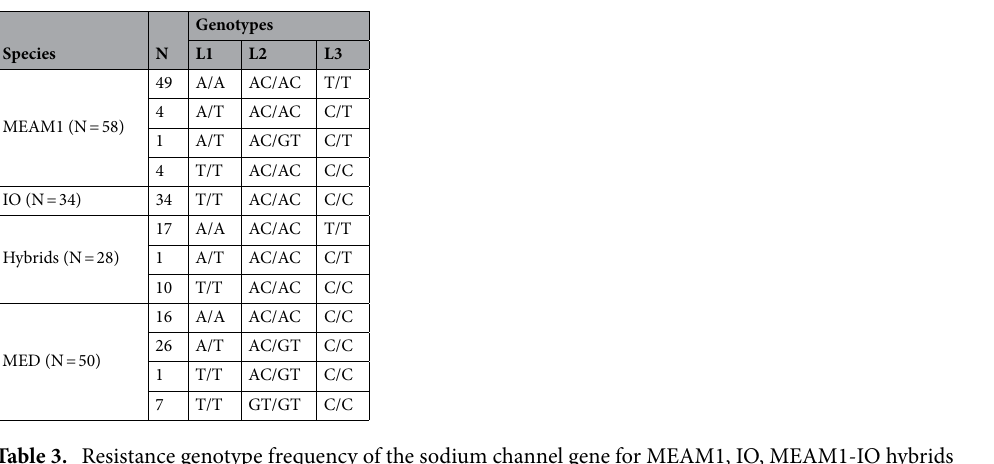
Table 3. Resistance genotype frequency of the sodium channel gene for MEAM1, IO, MEAM1-IO hybrids and MED DNA samples collected in La Réunion. Three loci were investigated: L1 (L925I), L2 (T929V) and L3 (the latter being in the intron region). I925 (‘A’ at L1) and V929 (‘GT’ at L2) are the resistant alleles, whereas L925 (‘T’ at L1) and T929 (‘AC’ at L2) are the susceptible